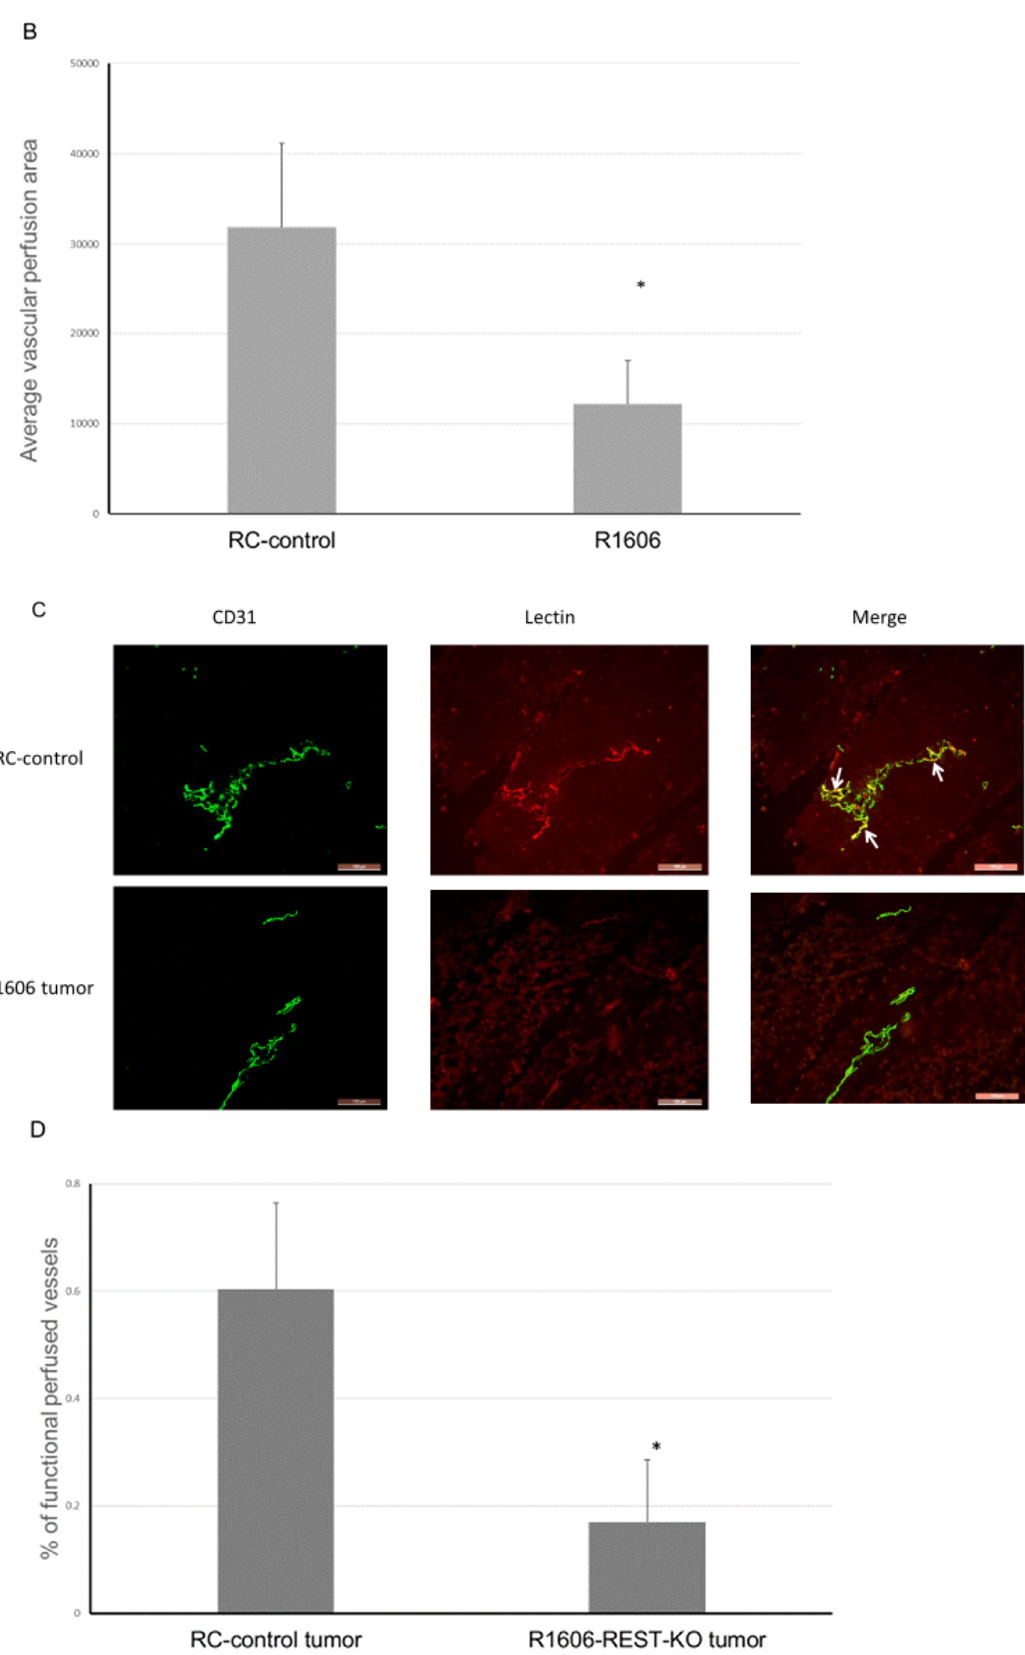
Figure 4. Down-regulation of REST reduced tumor vascular perfusion. ( A ) The mice (two groups tumor-bearing mice, 5 mice per group) were injected with DyLight 594–labeled Lycopersicon esculentum (tomato) lectin, then euthanized after 5 min. Tumor tissue sections were analyzed for